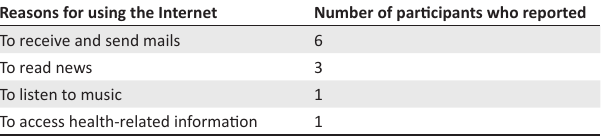
TABLE 2: Personal reasons for using Information and communication technology ( N = 6) . Reasons for using the Internet Number of participants who